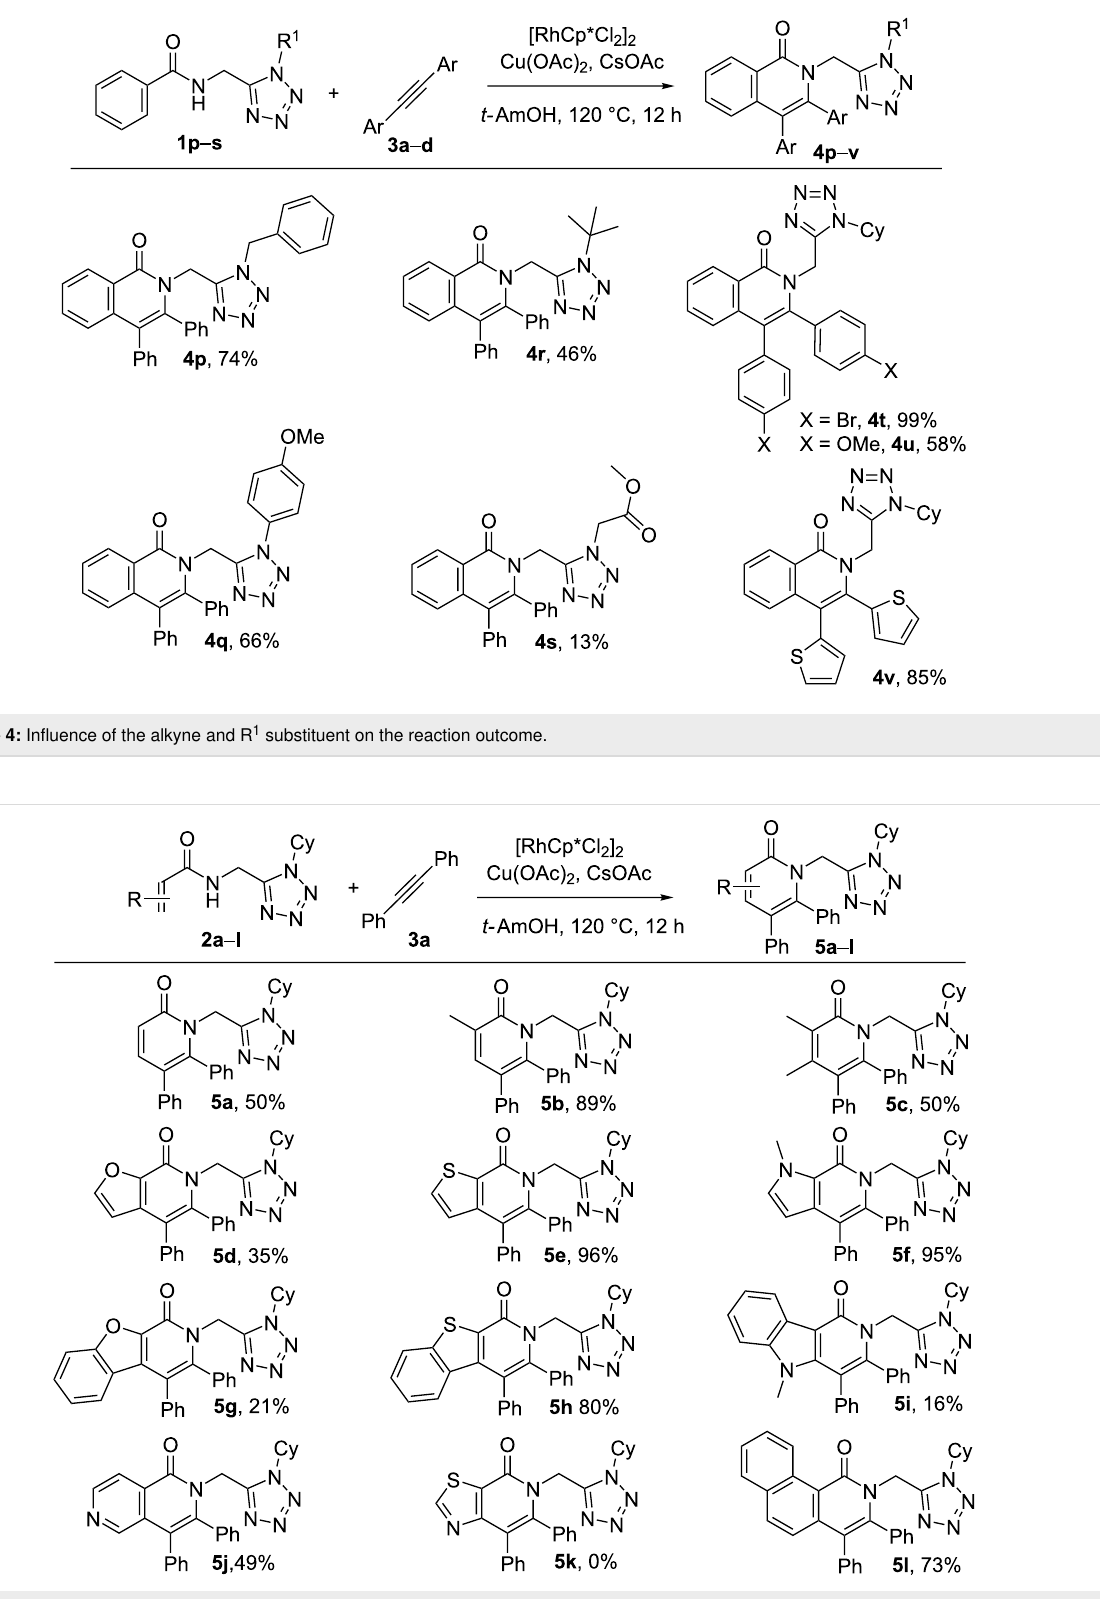
Scheme 5: Scope of acrylic, heterocyclic and ring-fused N -acylaminomethyl tetrazole